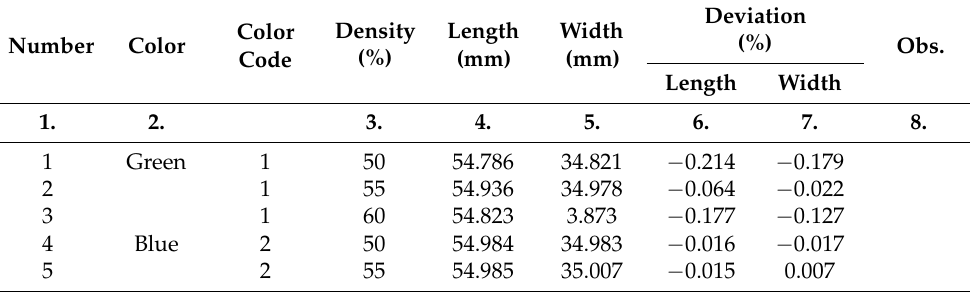
Figure 7. Definition of the length and width measurement. Table 3. Input data for the generation of the printed part and the size measuring